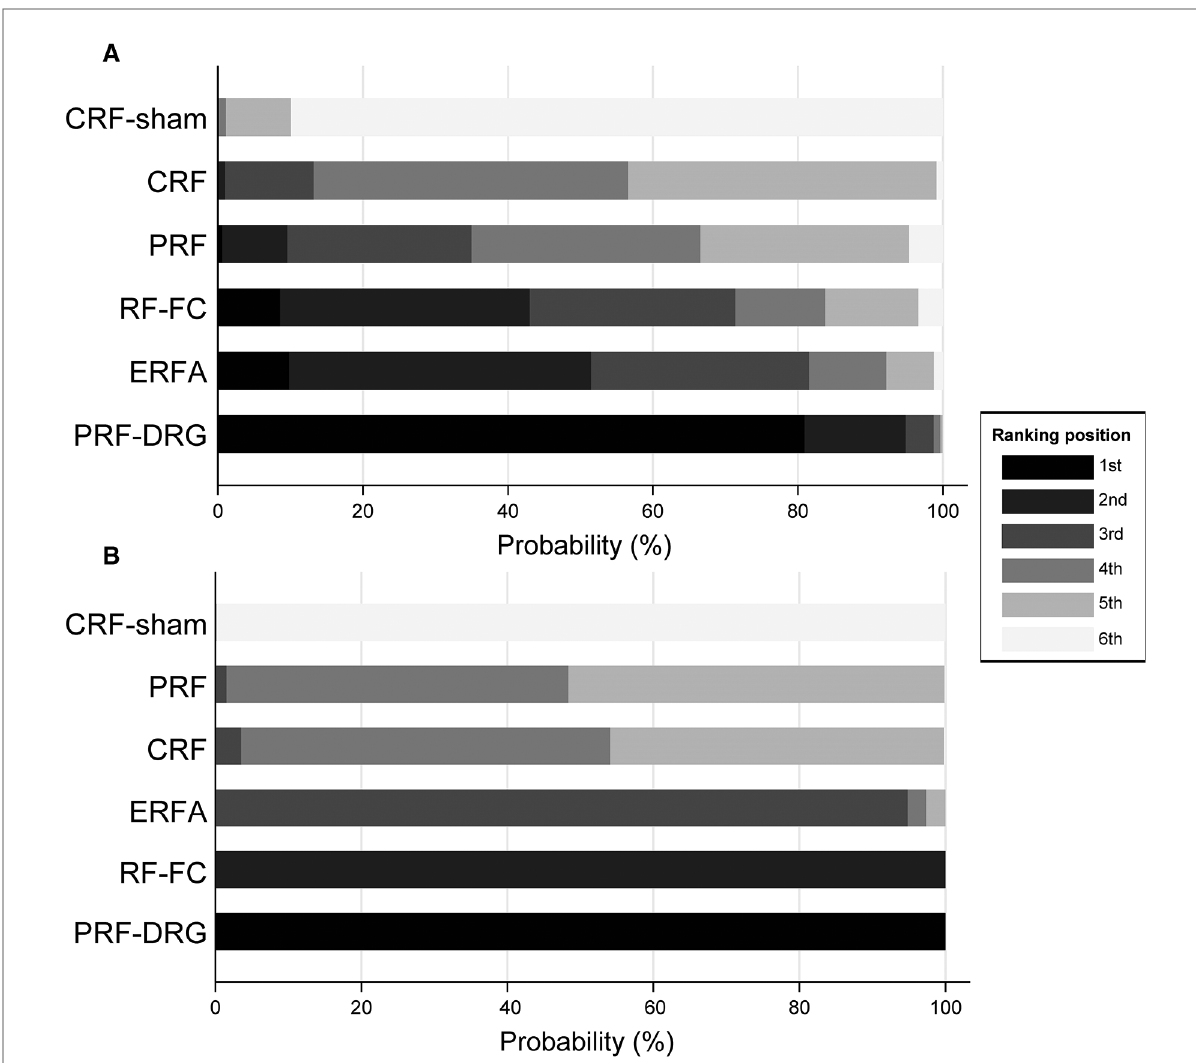
FIGURE 3 Treatment rank probabilities for pain relief for short-term ( A ) and long-term ( B ) follow-up. The order of the interventions on the vertical coordinate is based on the ef fi cacy from lowest to highest. The horizontal coordinate is the probability of ranking 1st –